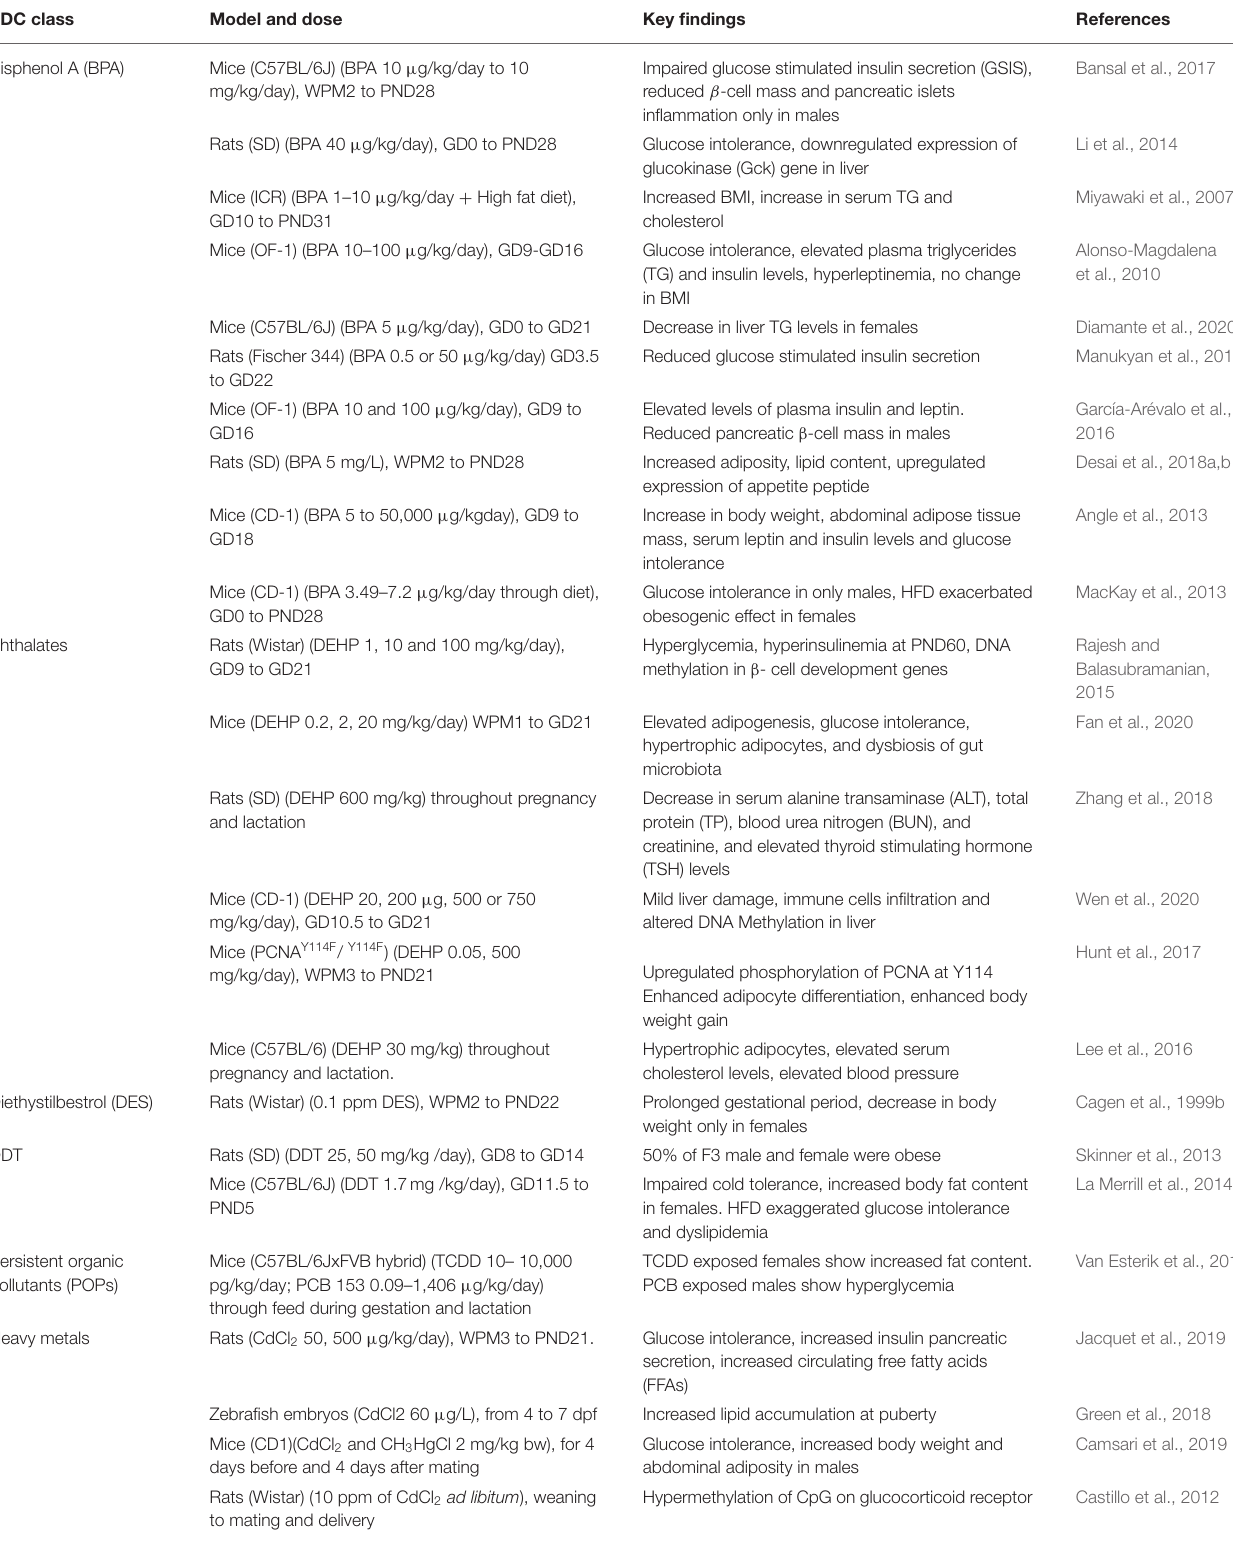
TABLE 2 | Major experimental studies describing maternal exposure to EDCs and risk of metabolic disorders in